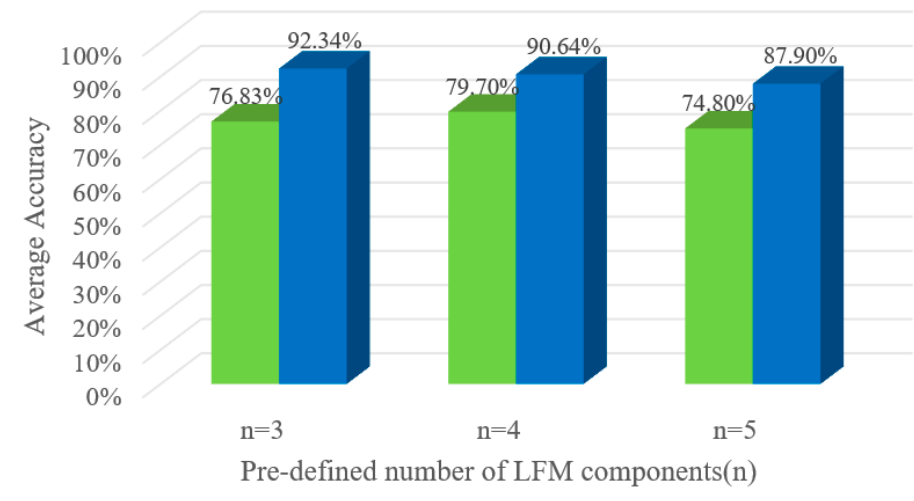
Figure 18. Average accuracy when different numbers of LFM components are predefined.